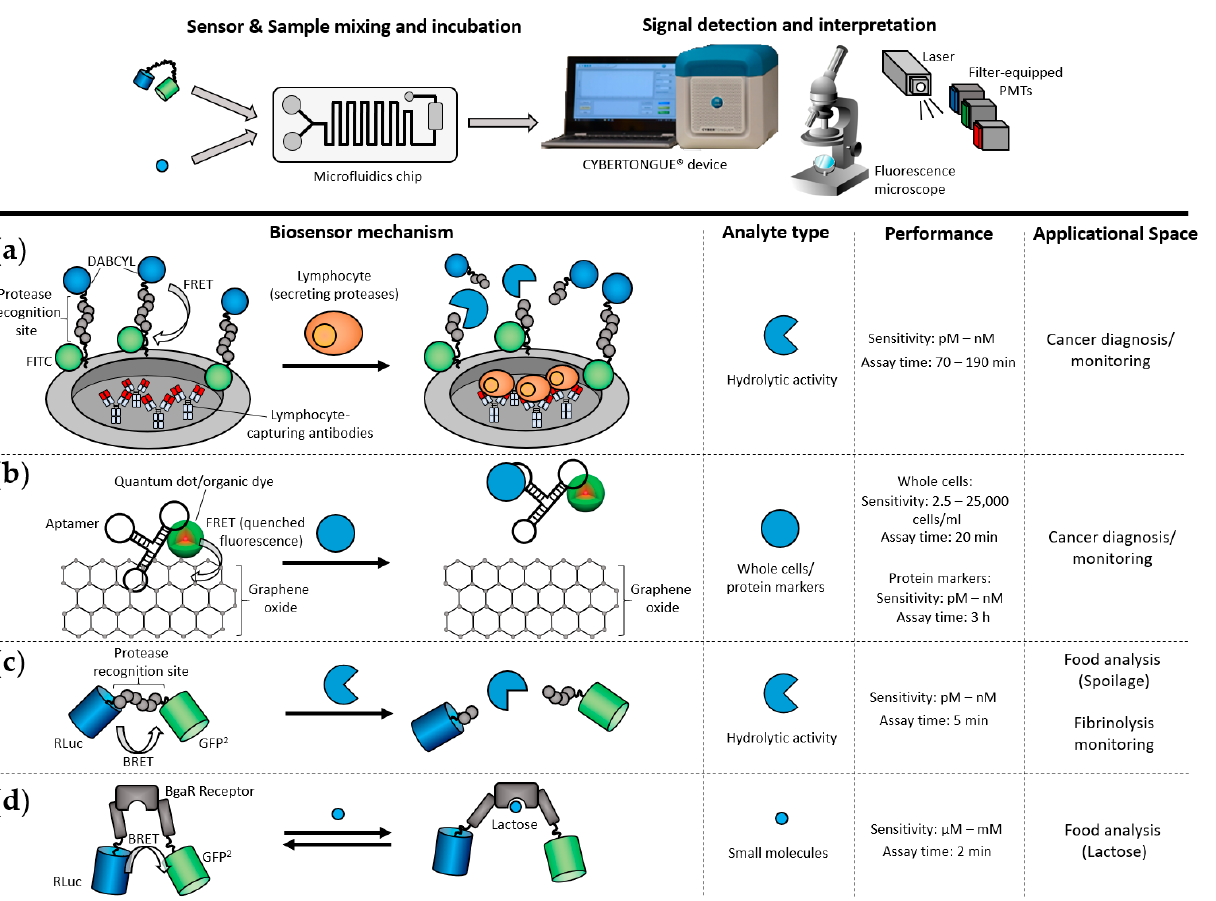
Figure 2. Examples of point-of-need (PON)-suitable applications using compact RET detection devices in combination with microfluidics. In one example, Bioluminescence Resonance Energy Transfer (BRET)-based biosensors are run on a microfluidics chip integrated into a compact device containing micro photon multiplier tubes ( µ PMTs). In other examples, FRET biosensor signals are recorded by using a fluorescence microscope or laser excitation followed by detection using PMTs. ( a ) Lymphocytes secreting Matrix metalloproteinase-9 (MMP9) are trapped by antibodies in a micro well located on a microfluidic chip. The peptides are labeled with Fluorescein isothiocyanate (FITC) and 4-(dimethylaminoazo)benzene- 4-carboxylic acid (DABCYL), and they contain MMP9-specific cleavage sites. These are immobilized close to the micro wells, to detect any MMP9 activity released by the cells [52]. ( b ) Aptamers, labeled with quantum dots (QDs), specific for cancer-related cells or protein markers are attached on a graphene monoxide layer. Binding of the target cells or proteins to their specific aptamer results in a release of the aptamer from graphene oxide, activating the fluorescence signal of the quantum dot/organic dye [53,54]. ( c ) CYBERTONGUE ® protease biosensors consist of the Renilla luciferase RLuc8 connected through a peptide linker, containing specific recognition sites for the target protease, to the Green Fluorescent Protein variant GFP 2 . Proteolytic activity exerted on the connecting peptide results in the dissociation of GFP 2 from RLuc8, leading to a profound change in BRET ratio [48,55,56]. ( d ) The CYBERTONGUE ® lactose biosensor consists of a lactose-binding protein tagged with RLuc8 and GFP 2 that undergoes a conformational change upon binding to lactose [57]. Binding of lactose results in the distancing of the two BRET components, thereby changing the BRET